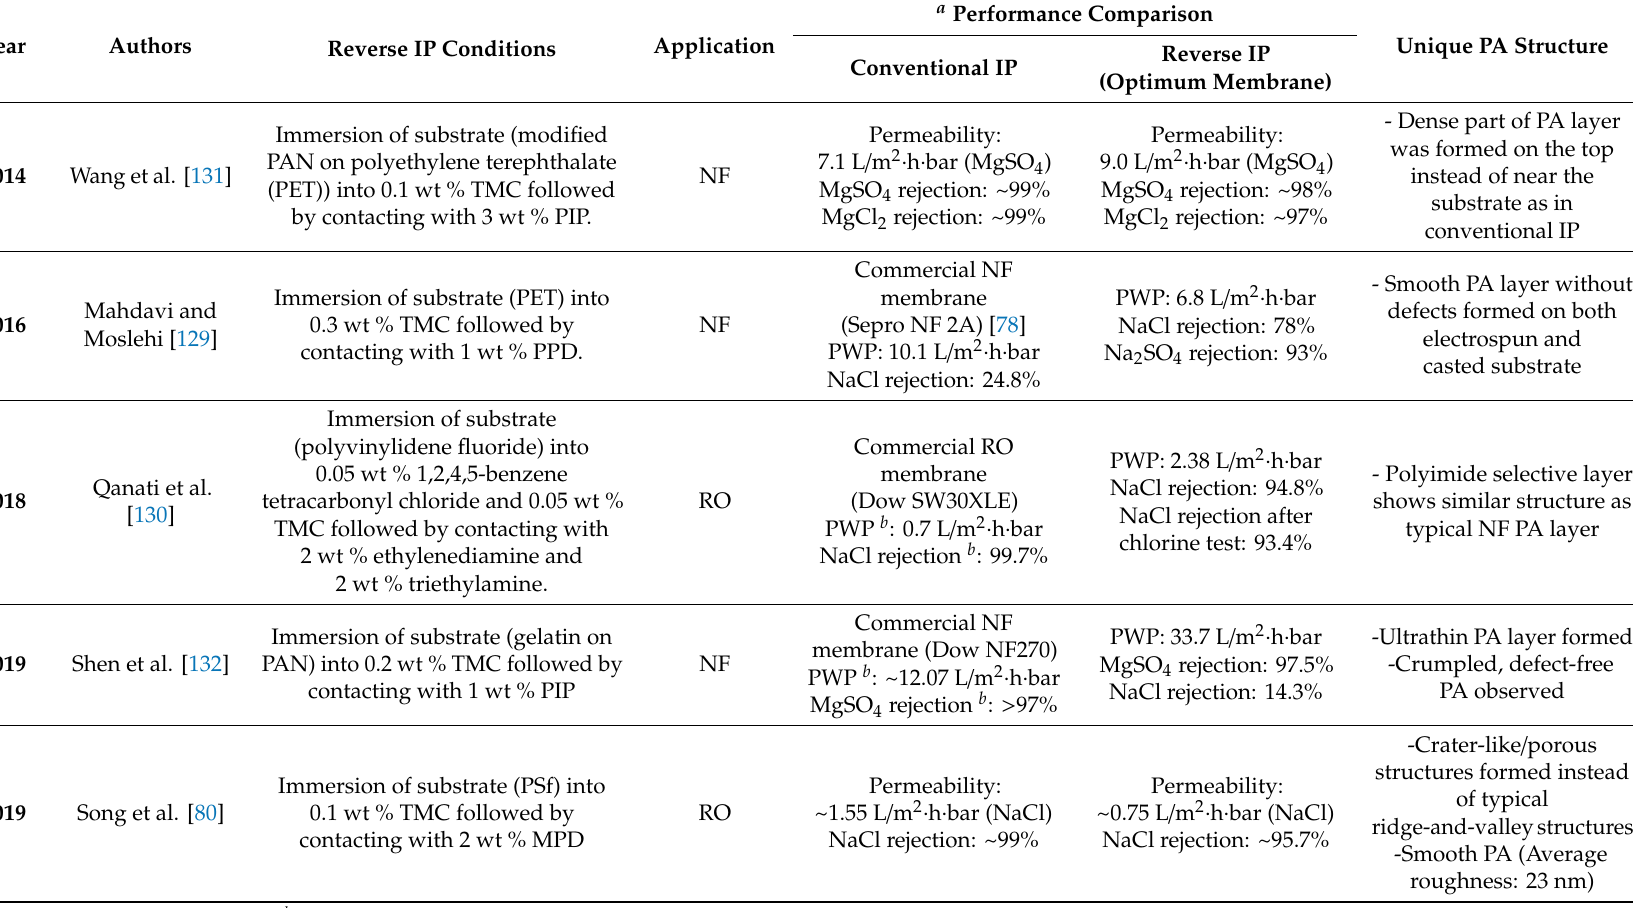
Table 7. Comparison of TFC membranes fabricated by using conventional and reverse